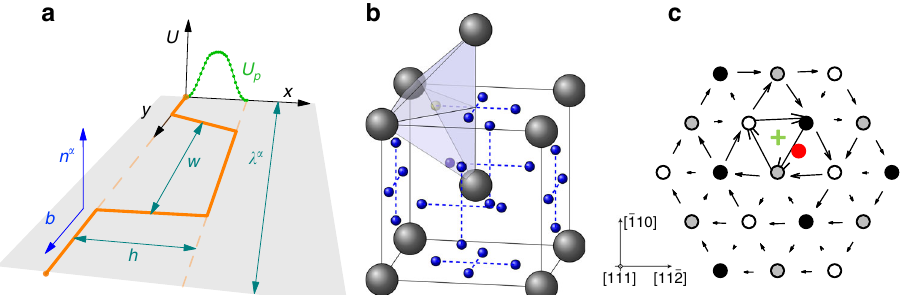
Fig. 2 Crystallographic features of the oxygen-dislocation system. a Schematic diagram of the basic kink-pair geometry on the Peierls energy substrate U x ). b and n α are the Burgers vector and the normal of the glide plane α . λ α is the length of an arbitrary straight screw dislocation segment on the same p ( plane, and h and w are the periodicity of the substrate potential and the stable kink-pair separation, respectively (adapted with permission from ref. 23 ). b Elementary bcc lattice cell showing lattice atoms (in gray) and tetrahedral interstitial sites (in blue), including a shaded tetrahedron with the interstitial site highlighted in its center. c Differential displacement map obtained using DFT calculations showing the stable con fi guration for the dislocation core-O complex (oxygen atom shown in red, core position shown in green). The resulting core structure changes from so-called “ easy ” (no oxygen) to “ hard ” (with oxygen). Figure 2b, c adapted with permission from ref.